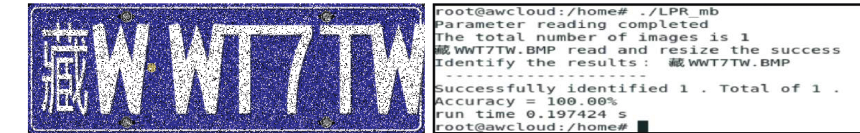
Figure 10: Salt and pepper noise interference and recognition results.